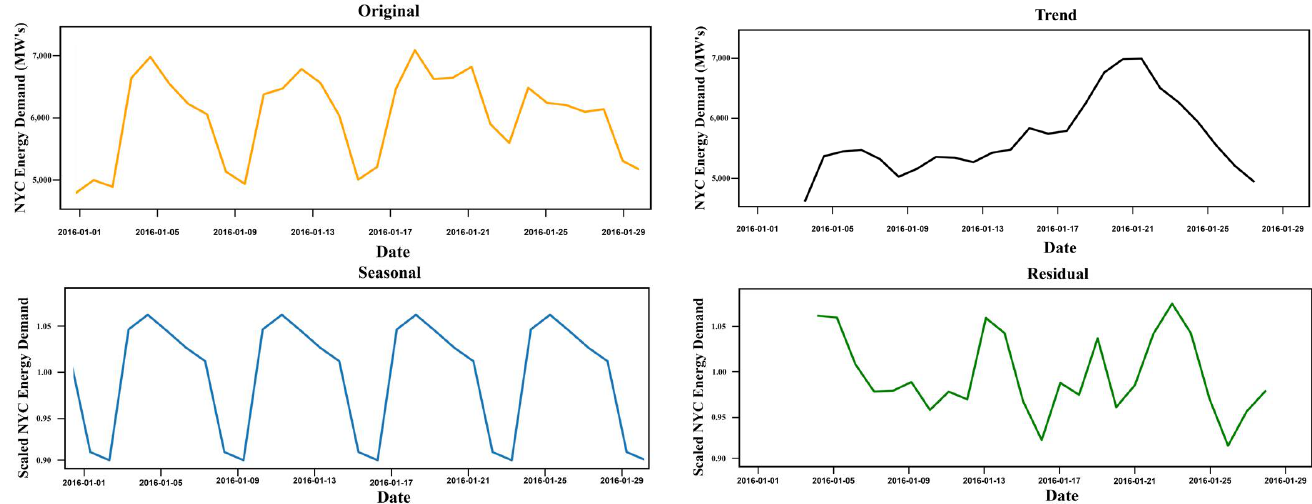
Figure 7. N.Y.C. original and decomposed data for January 2016.